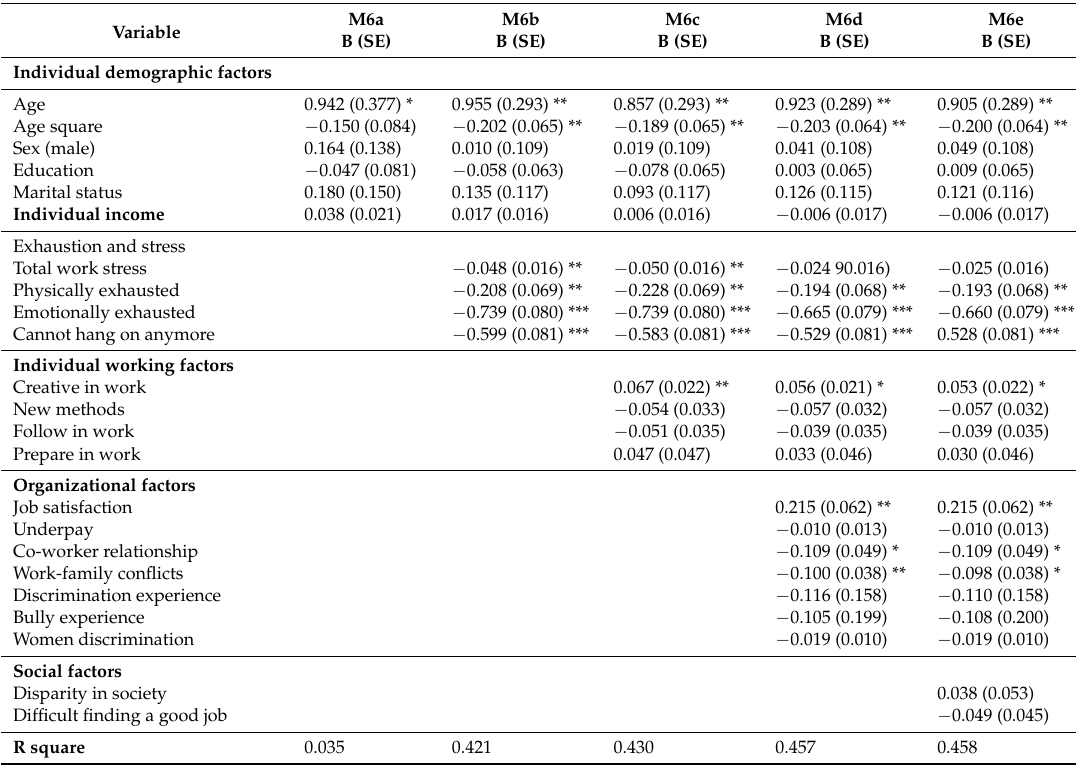
Table 5. Psychological health of workers and association with work stress and exhaustion by linear